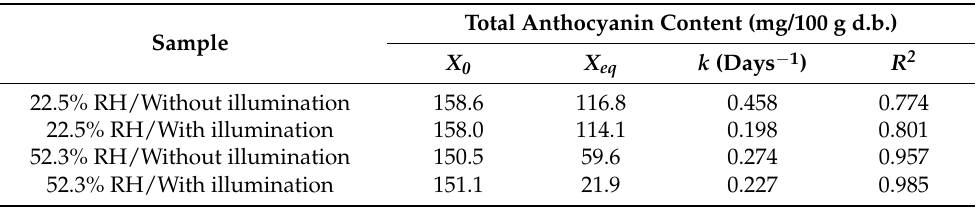
Table 2. Kinetic parameters for anthocyanins degradation during storage of strawberry leather.